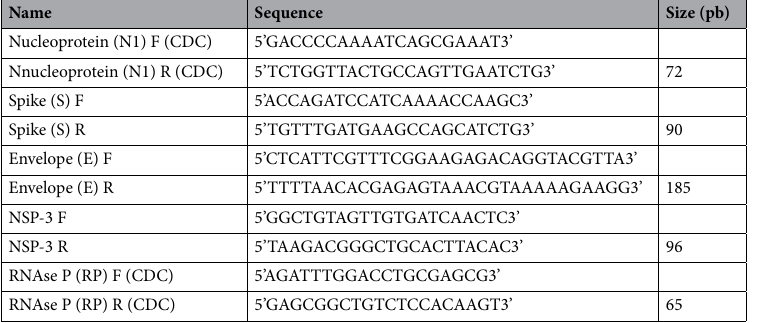
Table 2 were obtained based on the next equations: Sensitivity = TP/(TP + FN); Specificity = TN/(TN + FP); PPV = TP/(TP + FP); NPV = TN/(TN + FN); LR + = Sensitivity/ 1 − Specificity; LR- = 1 − Sensitivity/ Specificity and Cohen’s kappa = P0 − Pe/1 − Pe where; PPV (Positive Predictive Value); NPV (Negative Predictive Value); P0 = Overall accuracy of the model; Pe = agree- ment between the model predictions and the actual class values.